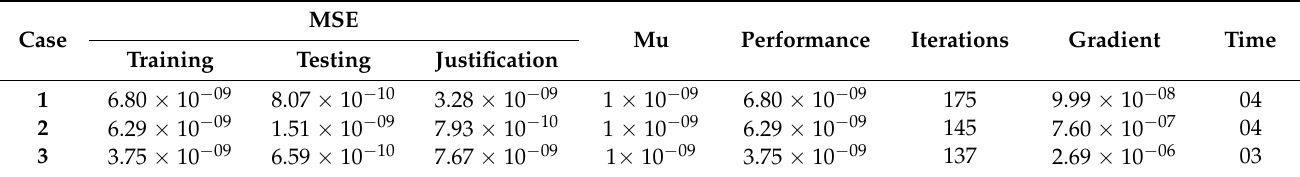
Table 2. SCGNNs performances for the FO-MML romantic